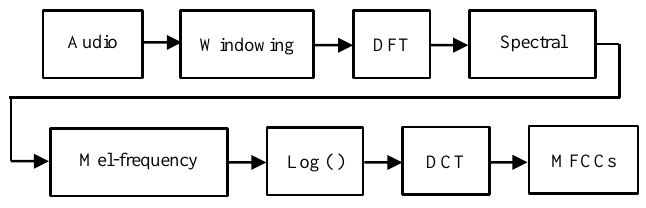
Figure 9. Flow chart of extracting Mel Frequency Cepstral Coefficients (MFCCs).